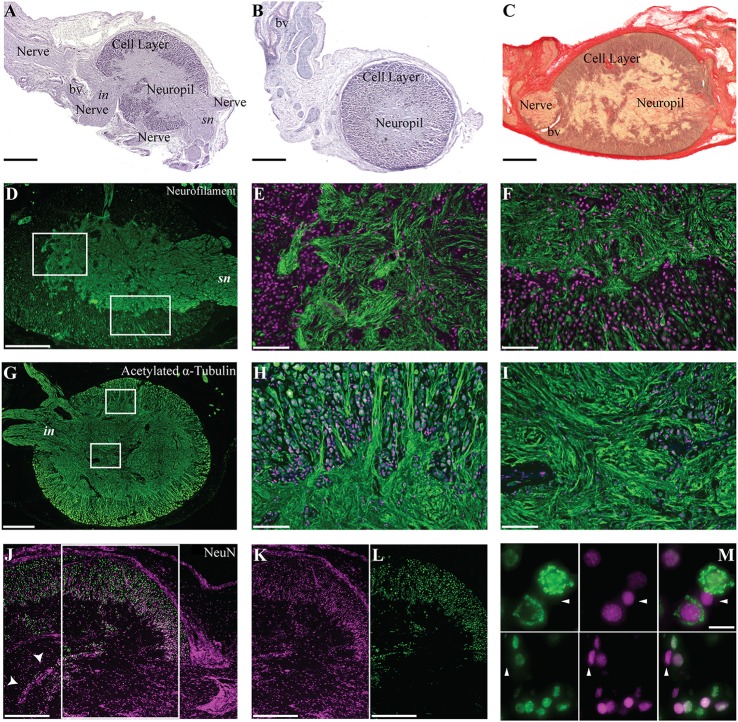
Morphological description of the octopus gastric ganglion. Hematoxylin and eosin (A,B) and Picro-Ponceau with hematoxylin (C) served to characterize the ganglion, with its cortical layer of neural cells (Cell layer) and internal neuropil. Nerve bundles are highlighted; in (A) intestinal (in) and sympathetic (sn) nerves are indicated; staining also revealed blood vessels (bv). Connective tissue and the cell layer surrounding and enveloping the ganglion is clearly identified after Picro-Ponceau with hematoxylin staining (C). (D–M) Fluorescent immunohistochemistry for (in green) neurofilament (D–F), acetylated alpha-Tubulin (G–I), and NeuN (J–M), DAPI is utilized as nuclear stain (magenta). Neurofilament marks the inner neuropil (D) and the intricate organization of fibers (enlargement in E), with some neural processes entering the cellular layer (enlargement in F). Acetylated alpha-tubulin (G–I) shows the external group (external layer) of cells larger than those distributed internally (internal layer) (H) with several processes progressing toward the internal neuropil (H,I). NeuN and nuclear stain (DAPI) merged image (J) are provided as separate channels in (K,L), respectively for areas corresponding to the white rectangle. A cell wall dividing the neuropil of the ganglion is clearly visible (J, arrowheads). Higher magnification to show the neurons positive for NeuN (green), DAPI (magenta), and merged channels in (M). The cells not positive for NeuN are indicated with arrowheads. Scale bars: 500 μm (D,G,J,K,L); 200 μm (A–C); 100 μm (E,F,H,I); 10 μm (M).